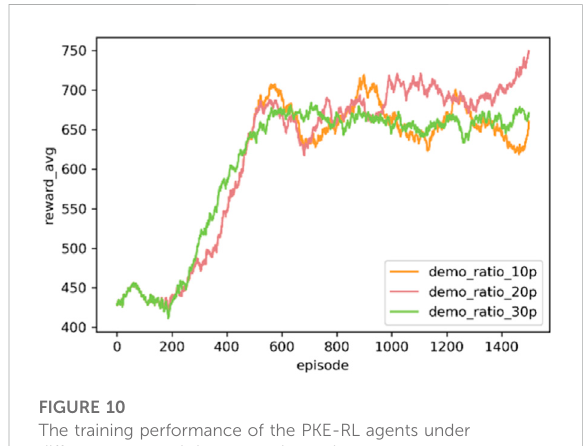
FIGURE 10 The training performance of the PKE-RL agents under different expected demonstration